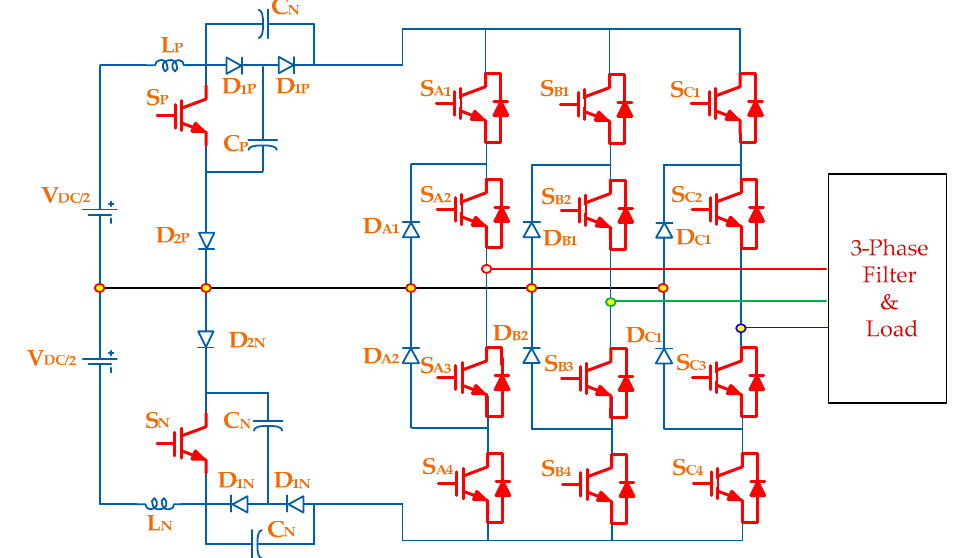
Figure 30. Switched-capacitor qSB based neutral point clamped multilevel inverter.